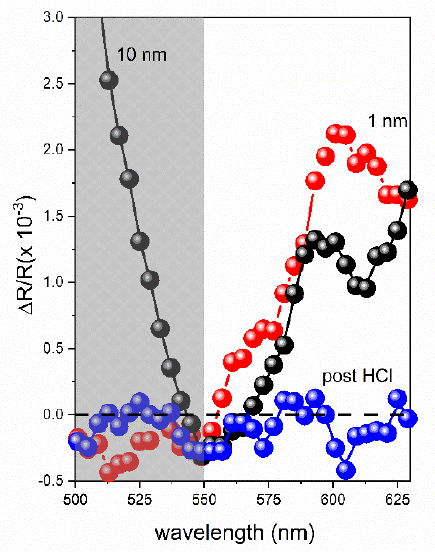
Figure 3. RAS analysis of the Q-band peak acquired on the 10 nm (black) and 1 nm (red) thick H 2 Po films on highly oriented pyrolytic graphite (HOPG). The optical anisotropy signal of the 10 nm thick sample after the exposure to acid vapors (blue) is also